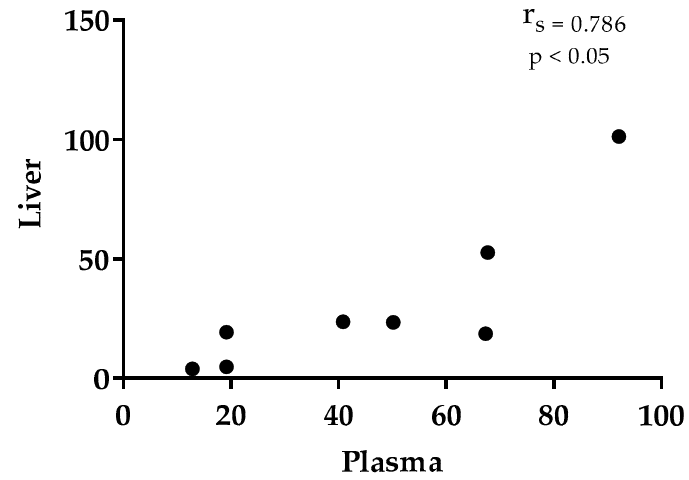
Figure 2. Correlation between liver (ng/g DM) and plasma (ng/mL).